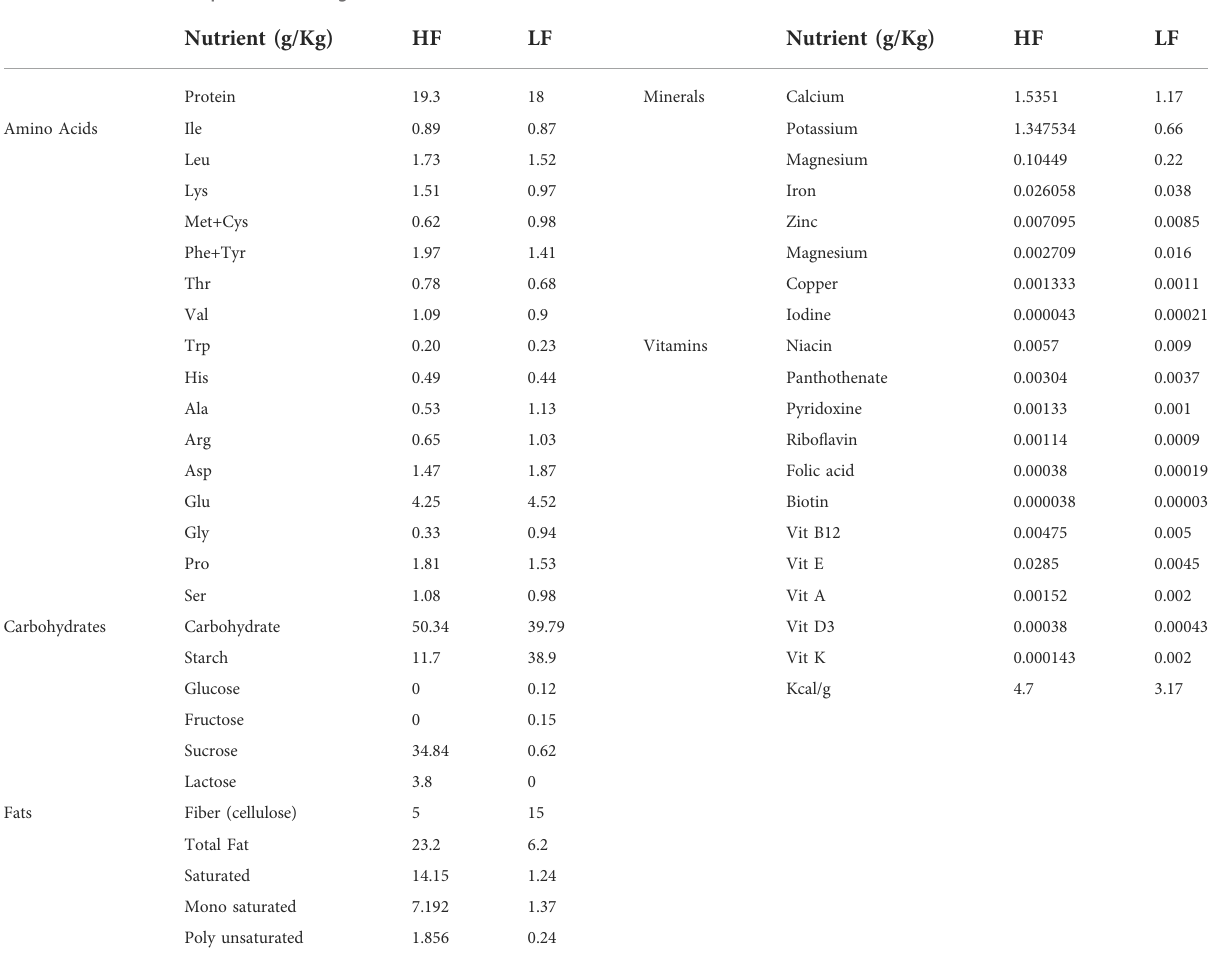
TABLE 2 Mouse diet compositions for High Fat (HF) and Low Fat